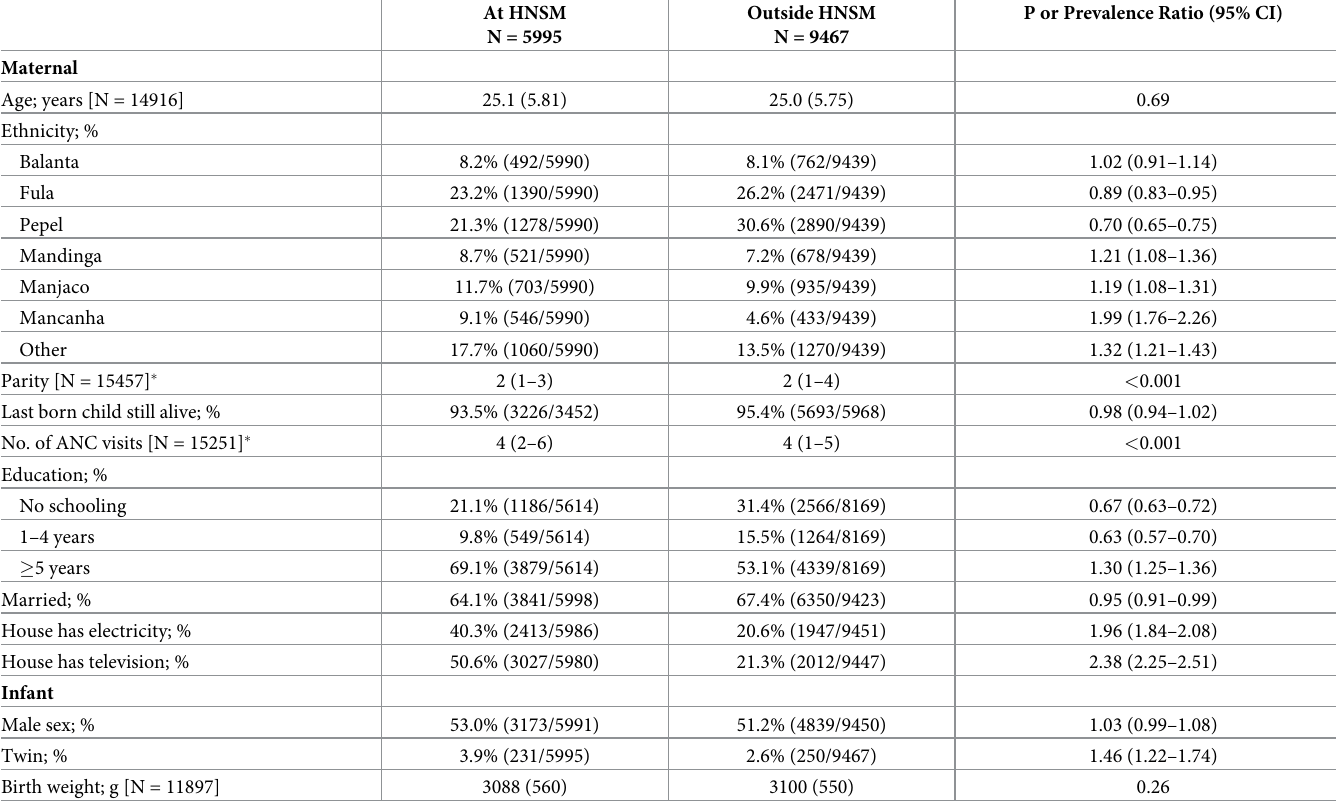
Table 1. Characteristics among HNSM vs. Non-HNSM deliveries from the community